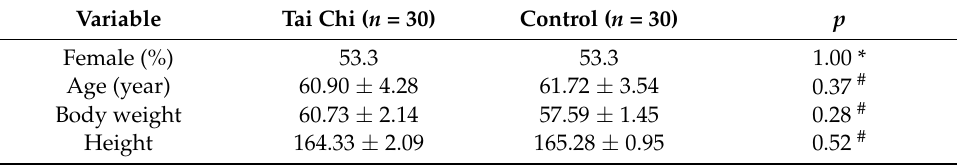
Table 1. Demographic characteristics of all subjects in both the Tai Chi and control groups. Variable Tai Chi ( n = 30) Control ( n = 30) p Female (%) 53.3 53.3 1.00 * Age (year) 60.90 ± 4.28 Body weight 60.73 ± 2.14 Height 164.33 ± 2.09 165.28 ± 0.95 0.52